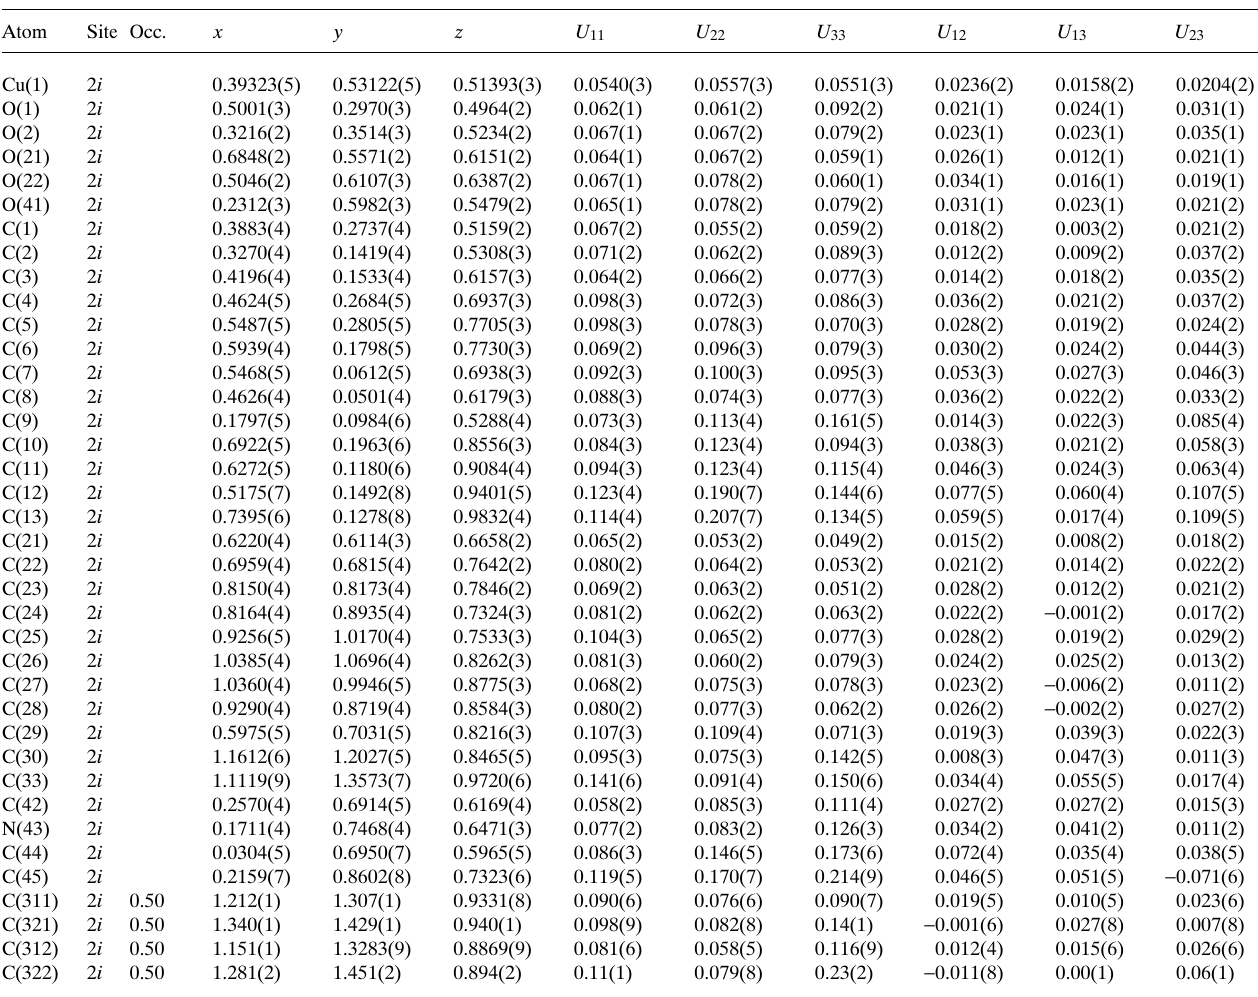
Table 3. Atomic coordinates and displacement parameters (in Å 2 ) .